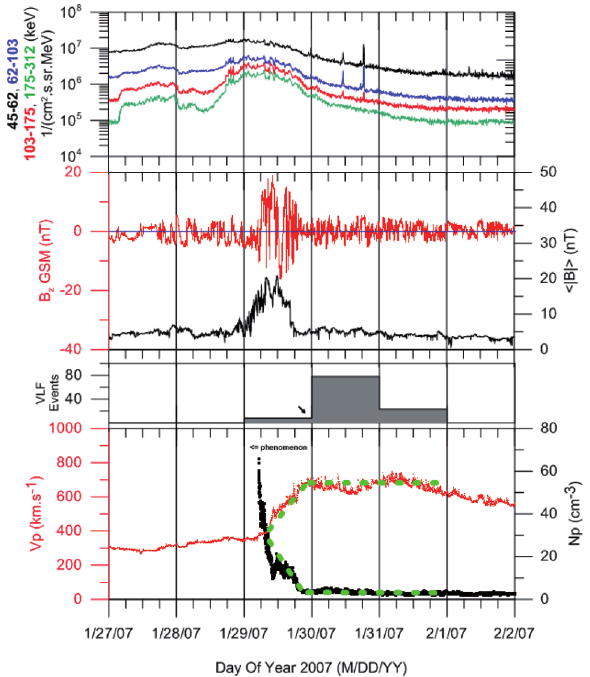
Figure 5. Case A: Jan 29-31. ACE data. Top: Electron fluxes (Ep) from EPAM. Middle: IMF (|B| and Bz) from MAG. Bottom: Solar wind proton density (Np) and velocity (Vp) from SWEPAM.